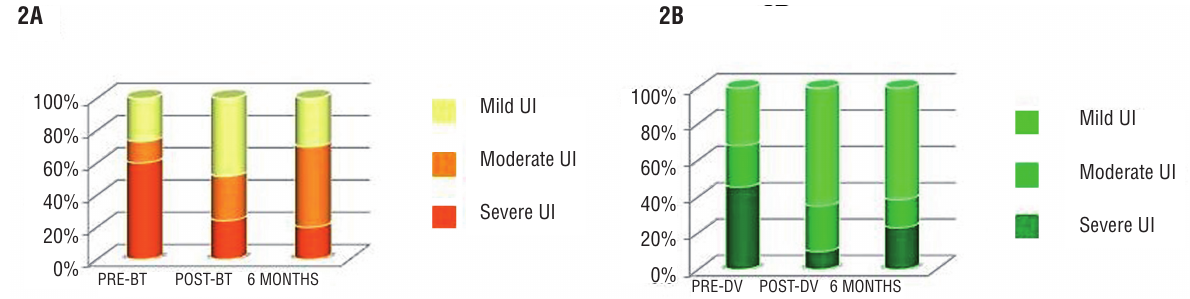
Figure 2 - Percentage of mild, moderate or severe erectile dysfunction pre-treatment, 3-6 months after treatment and from month 6